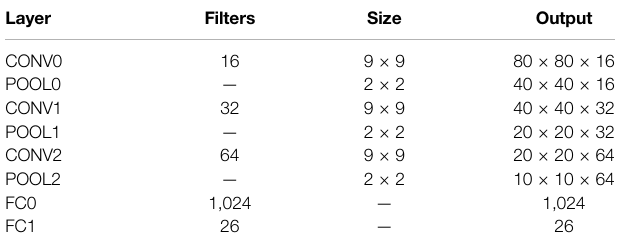
TABLE 1 | | Architecture of proposed CNN algorithm.